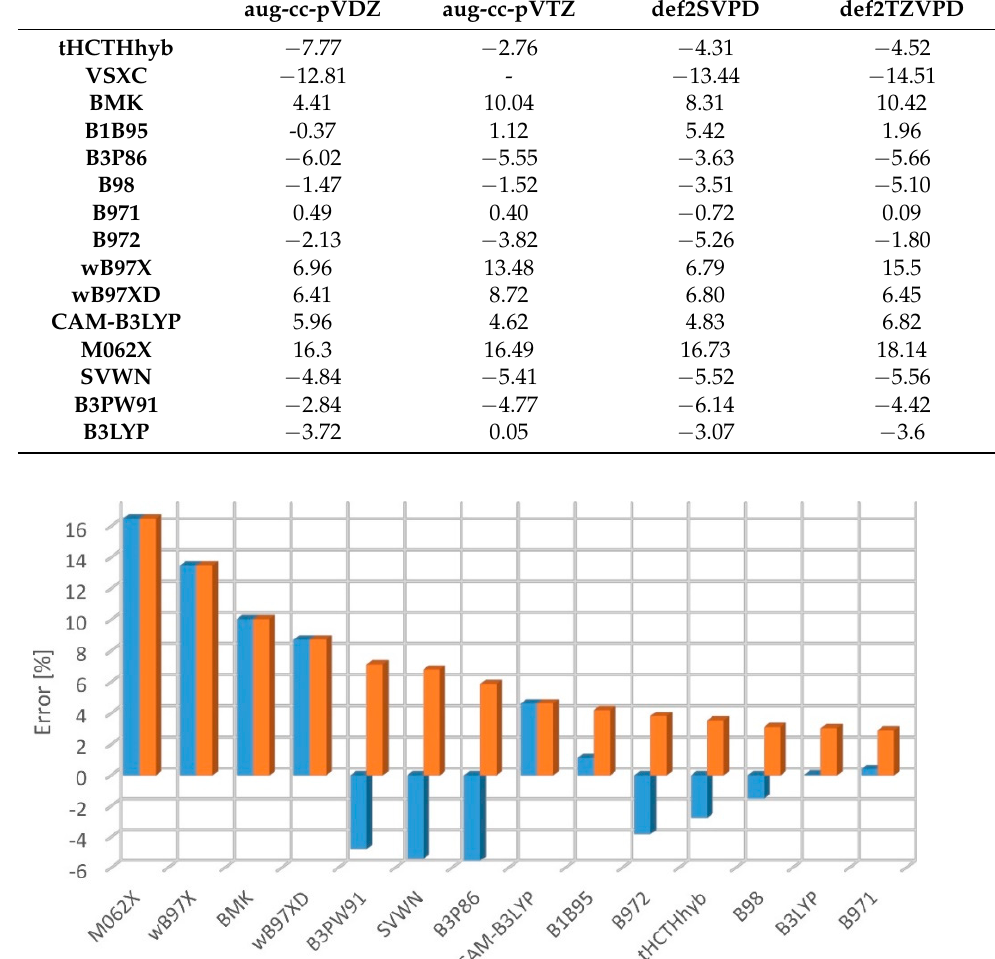
Figure 5. Mean percent difference (blue) and mean absolute percent error (orange) for the DFT/aug-cc-pVTZ-derived singlet-triplet excitation energy predictions, with respect to the experimental Ar-matrix values.